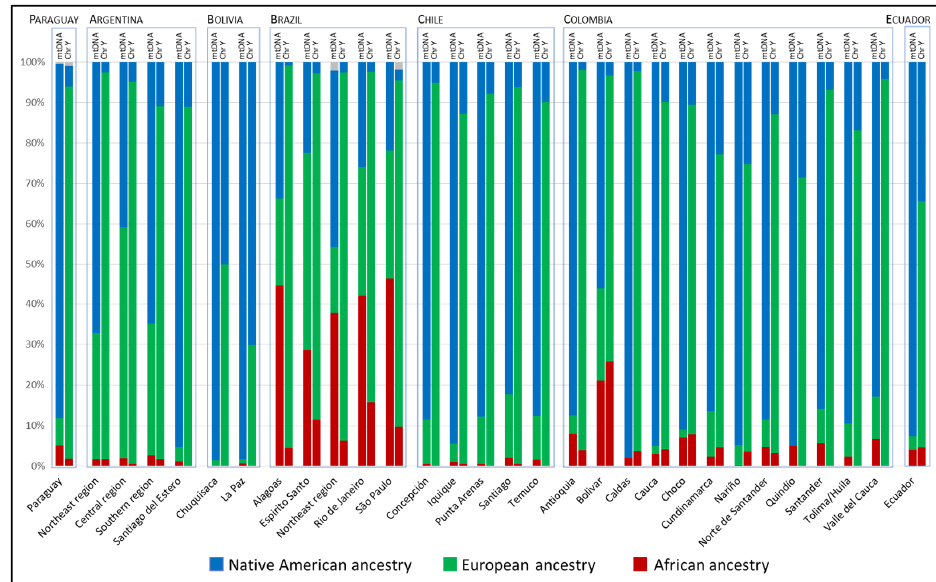
Figure 3. Maternal and paternal ancestry proportions in admixed South American populations.